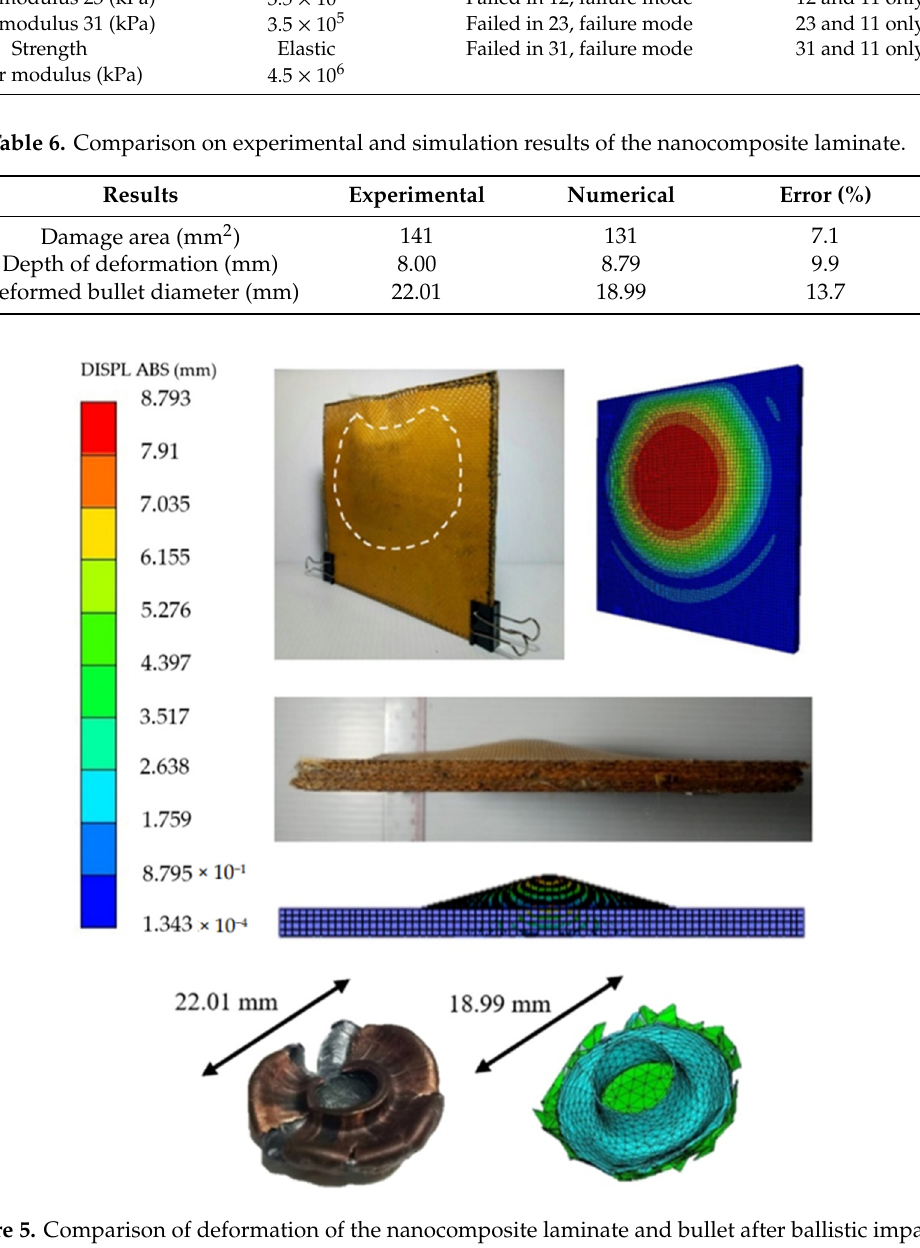
Figure 5. Comparison of deformation of the nanocomposite laminate and bullet after ballistic impact.